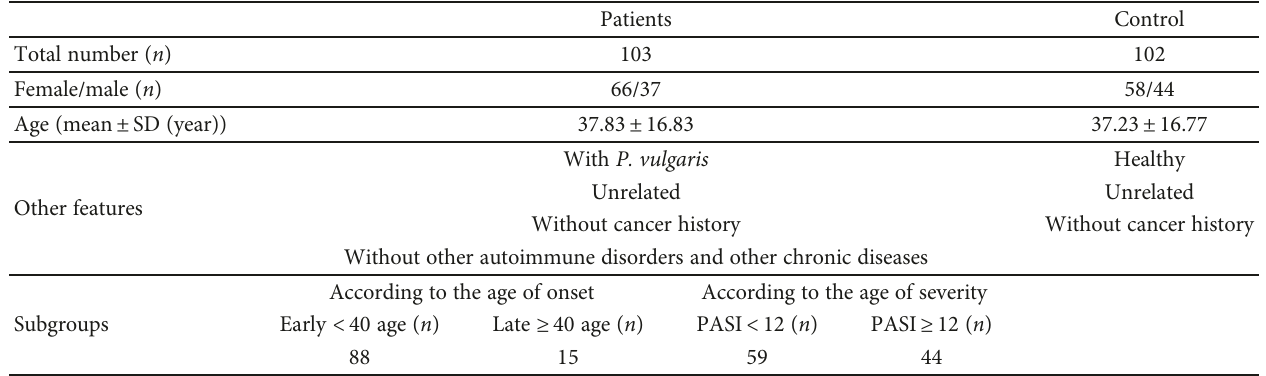
Table 1: Characteristics of the study